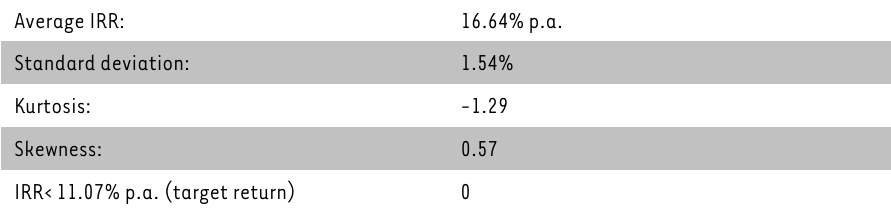
Volatility of the IRRs of the investments of Set B